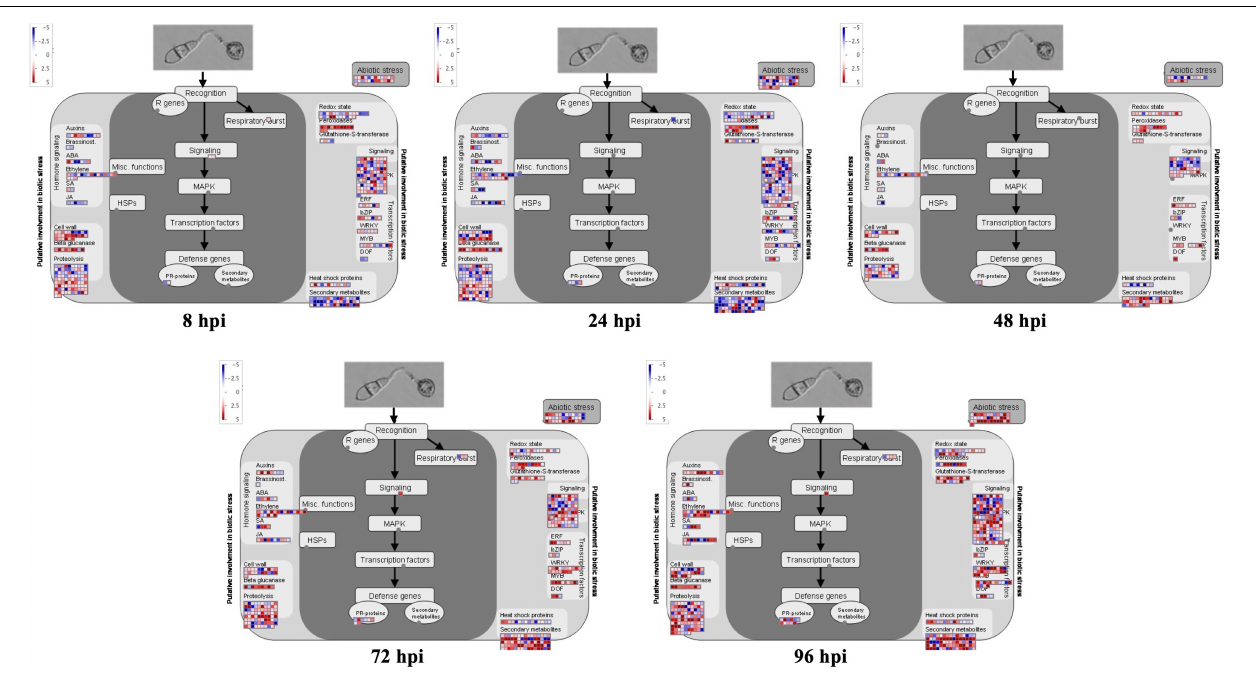
FIGURE 2 | MapMan overviews of biotic stress display transcriptional change at 8, 24, 48, 72, and 96 hpi. CDEGs are significantly upregulated (red) and downregulated (blue) in inoculated leaf samples. Individual genes are represented by small squares. The scale bar displays log2-transformed fold